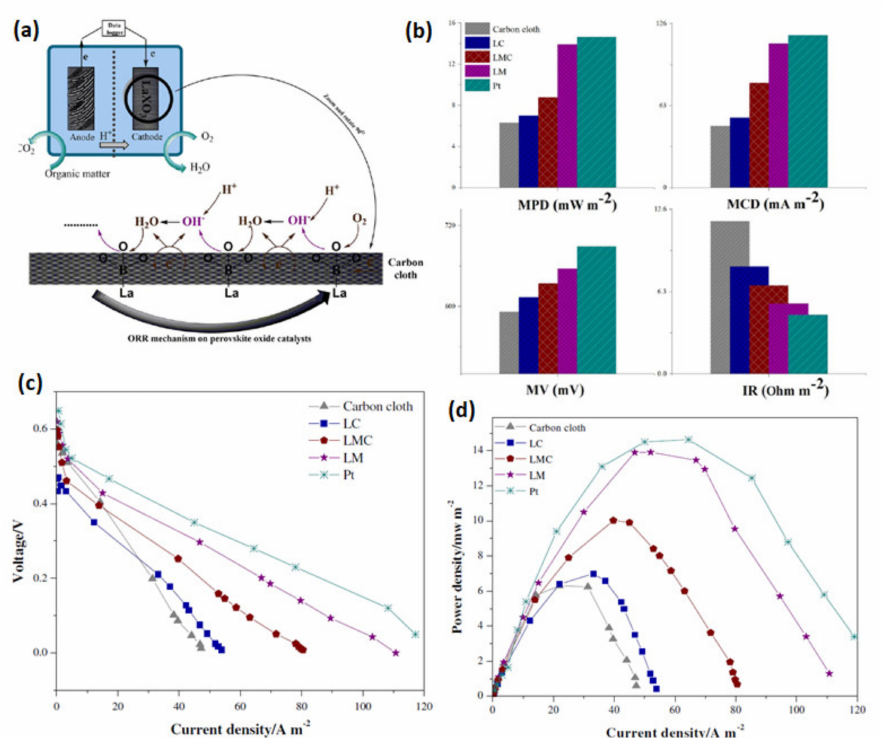
Figure 6. ( a ) Pictorial representation of ORR pathway on LaCo 0.5 Mn 0.5 O 3 ; ( b ) a column/bar diagram of the obtained results of the MFC with La-based perovskite catalyst in comparison with bare and Pt- coated carbon cloth cathode; ( c ) polarization curves; ( d ) power density curves of different electrodes. (Reprinted with permission from [5]. Copyright 2020, Springer, Open